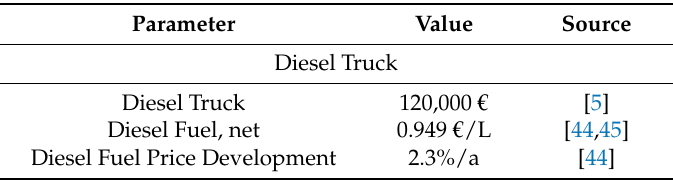
Table A3. Costs parameters for diesel truck used in LCC